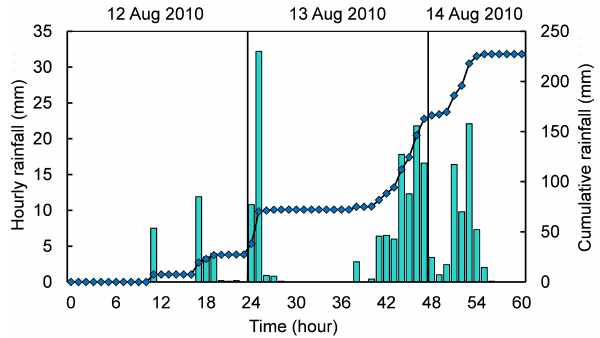
Figure 5. Rainfall process of the August 2010